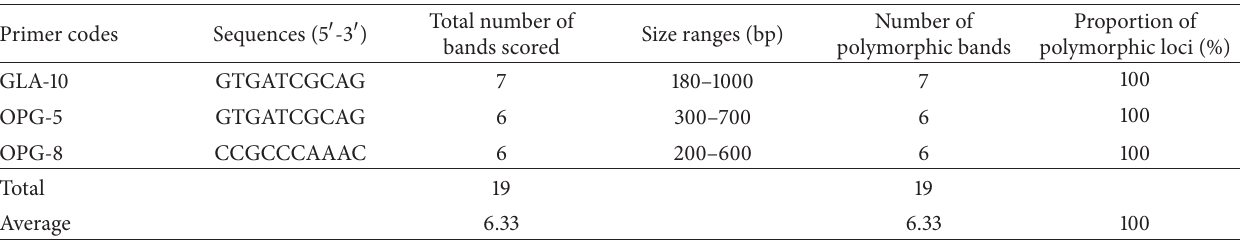
Table 3: Clustering patterns of 20 genotypes of lentil based on Euclidean distance following Ward’s method and the genotypes included in respective clusters.